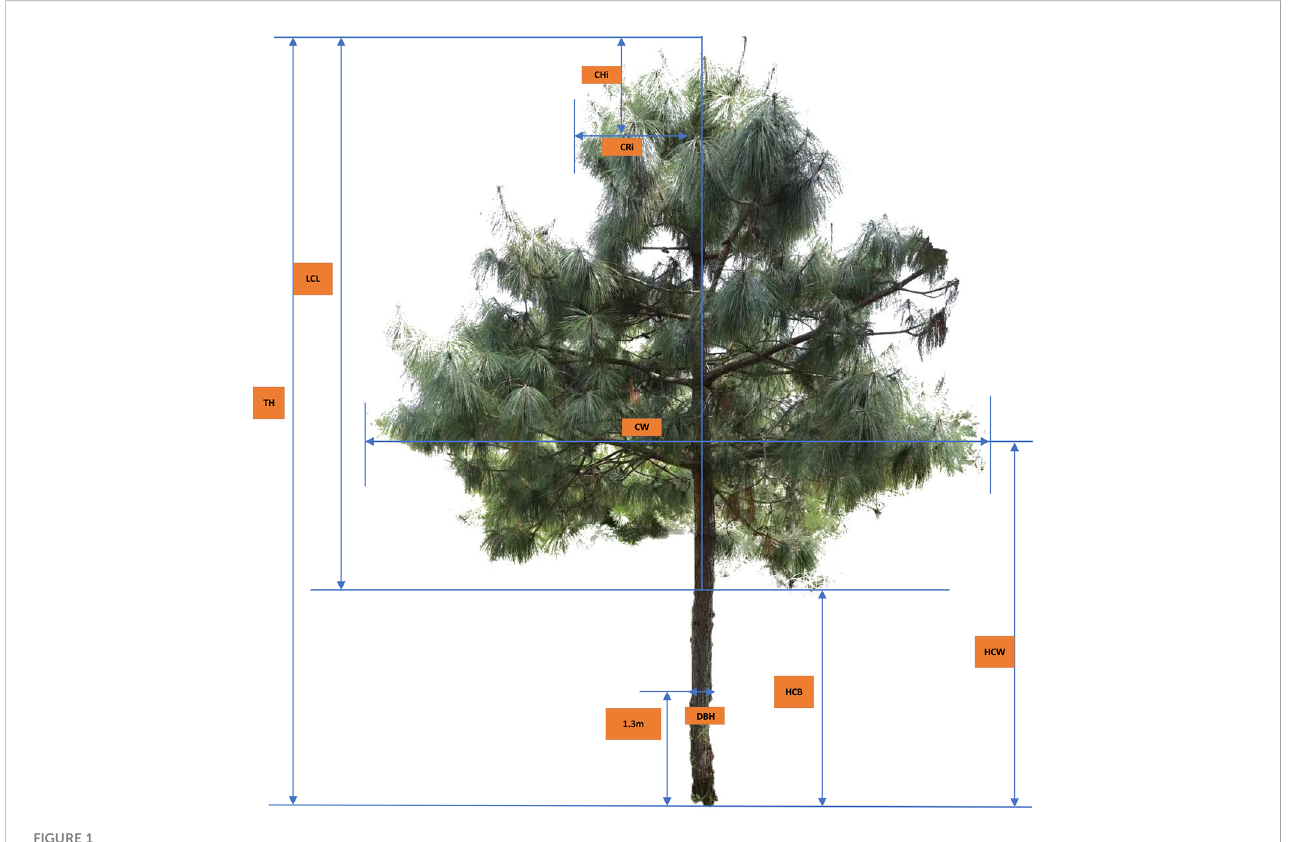
FIGURE 1 Tree crown measurement diagram of for Pinus yunnanensis